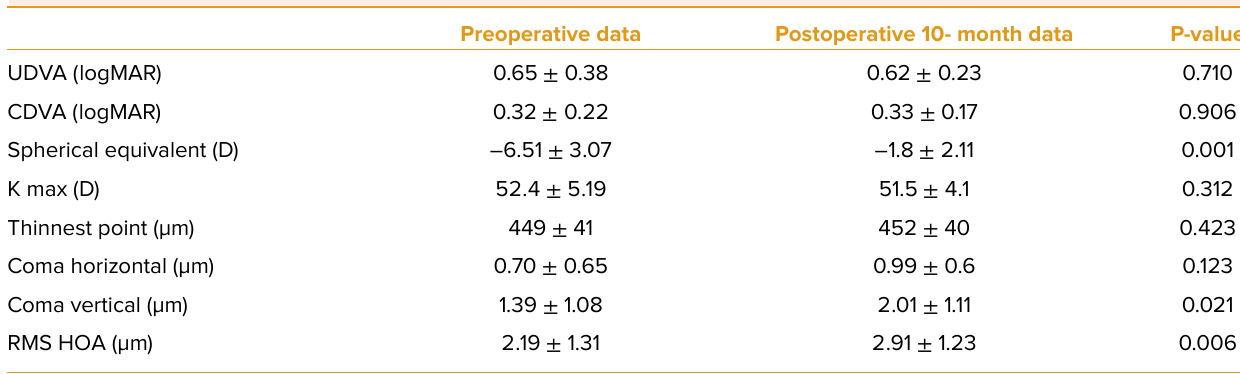
Table 2. Change in variables in the MyoRing group after 10 months of follow-up compared to